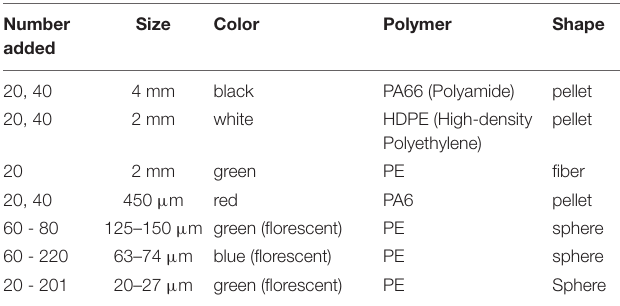
TABLE 1 | Set of spiked MP of various size (longest dimension), color, polymer type and shape. Number